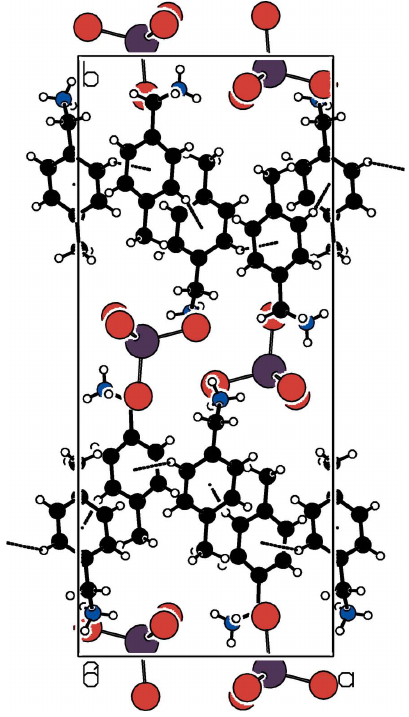
Figure 3 Partial packing diagram showing the C2—H2 (cid:3)(cid:3)(cid:3) (cid:2) interaction involving the C9–C14 benzene ring and C14—H14 (cid:3)(cid:3)(cid:3) (cid:2) interaction involving the C1–C6 benzene ring.